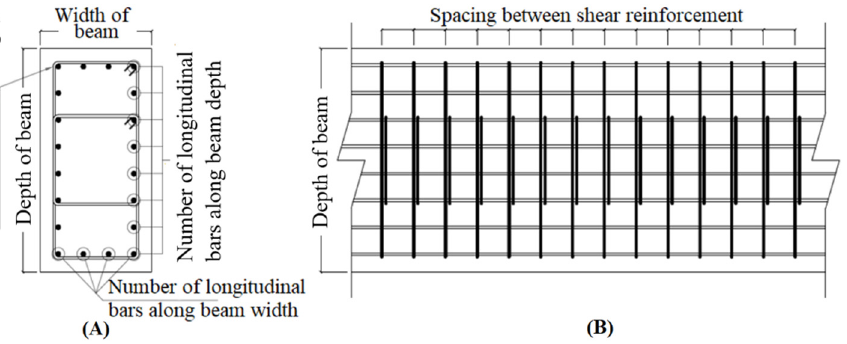
Figure 4. Beams controlling design variables (V 8 and V 9 ): ( A ) Beam section view; ( B ) Beam elevation view.